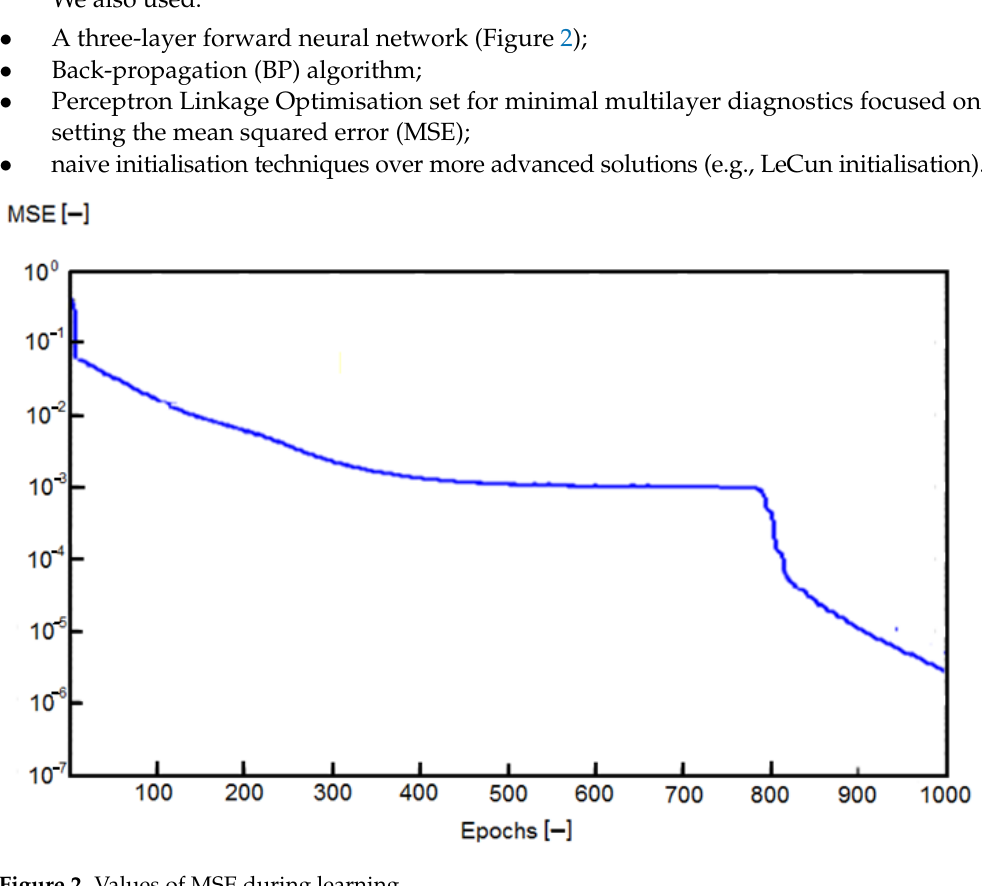
Figure 2. Values of MSE during learning.